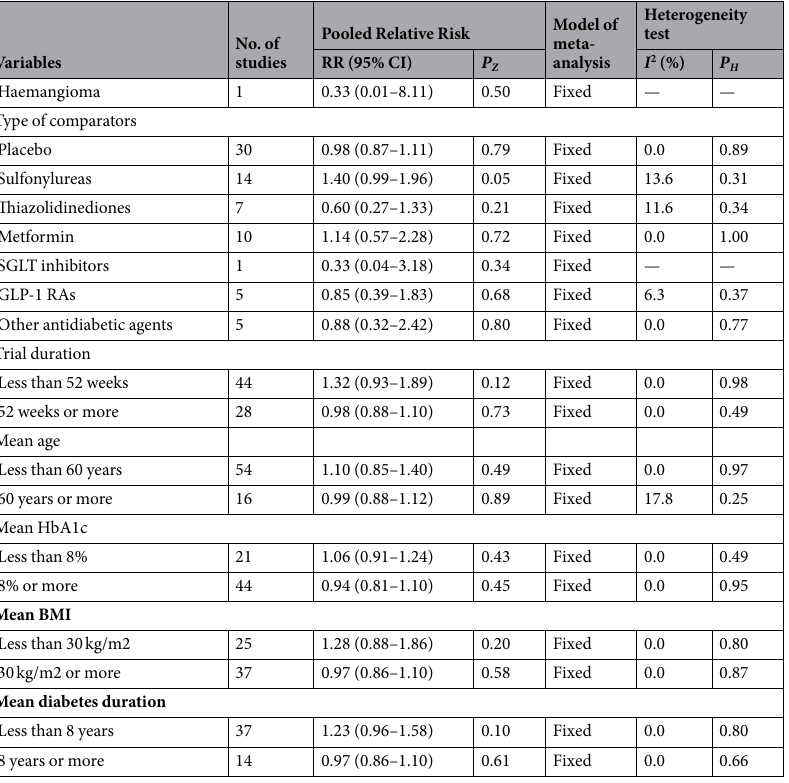
Table 2. Meta-analysis results. SGLT: sodium-glucose co-transporter; GLP-1 RAs: glucagon-like peptidase-1 receptor agonists.